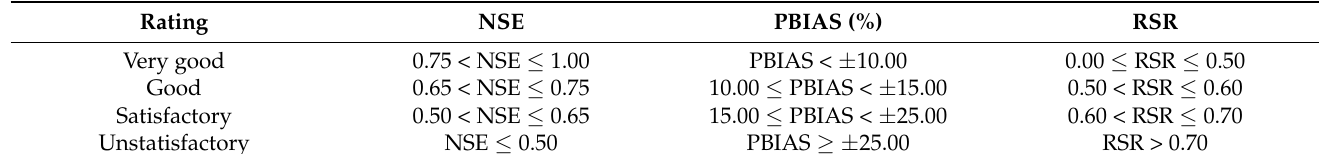
Table 3. General Performance Ratings of Statistical Indices for Monthly Streamflow Simulation.